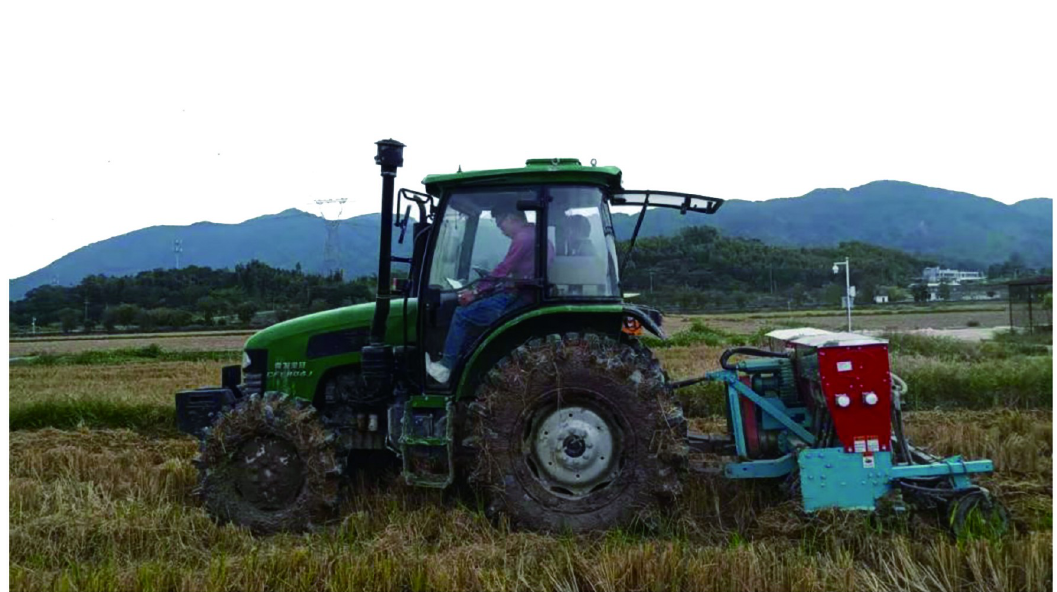
Fig 1. Environment of tractor vibration